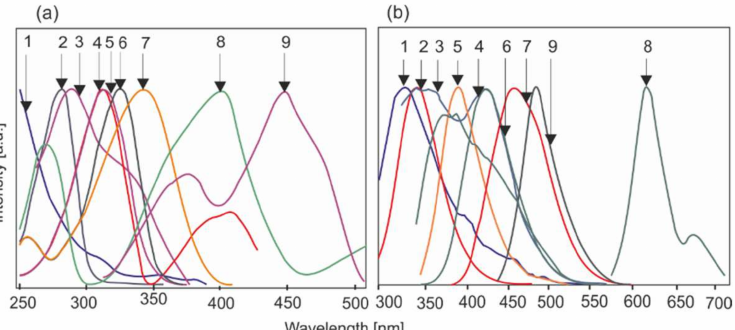
Figure 3. Spectral characteristics of potential endogenous fluorophores: 1—collagen,